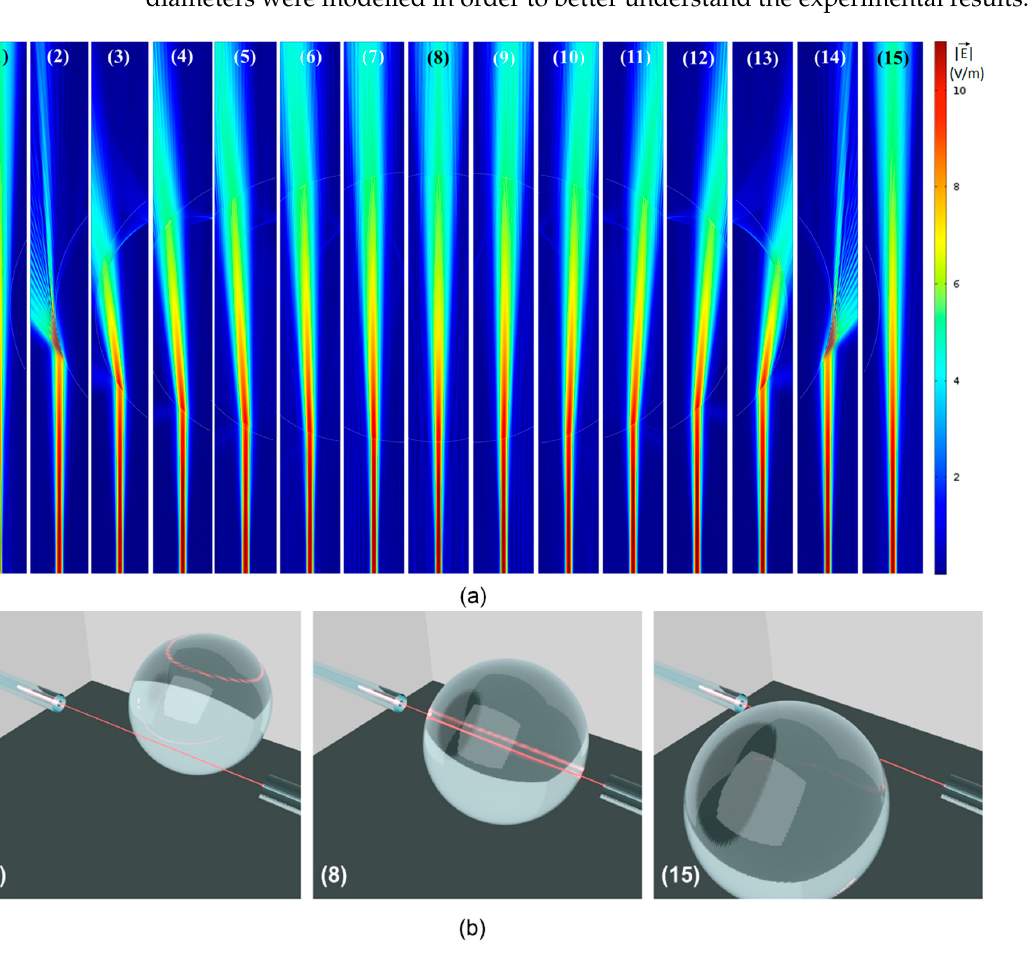
Figure 4. ( a ) Magnitude of the electric field vector for 15 different positions of the input/output fibers with respect to the droplet. The droplet moves 20 µm between positions. ( b ) Illustration of the positions 1, 8, and 15-of the input/output fibers with respect to the droplet.